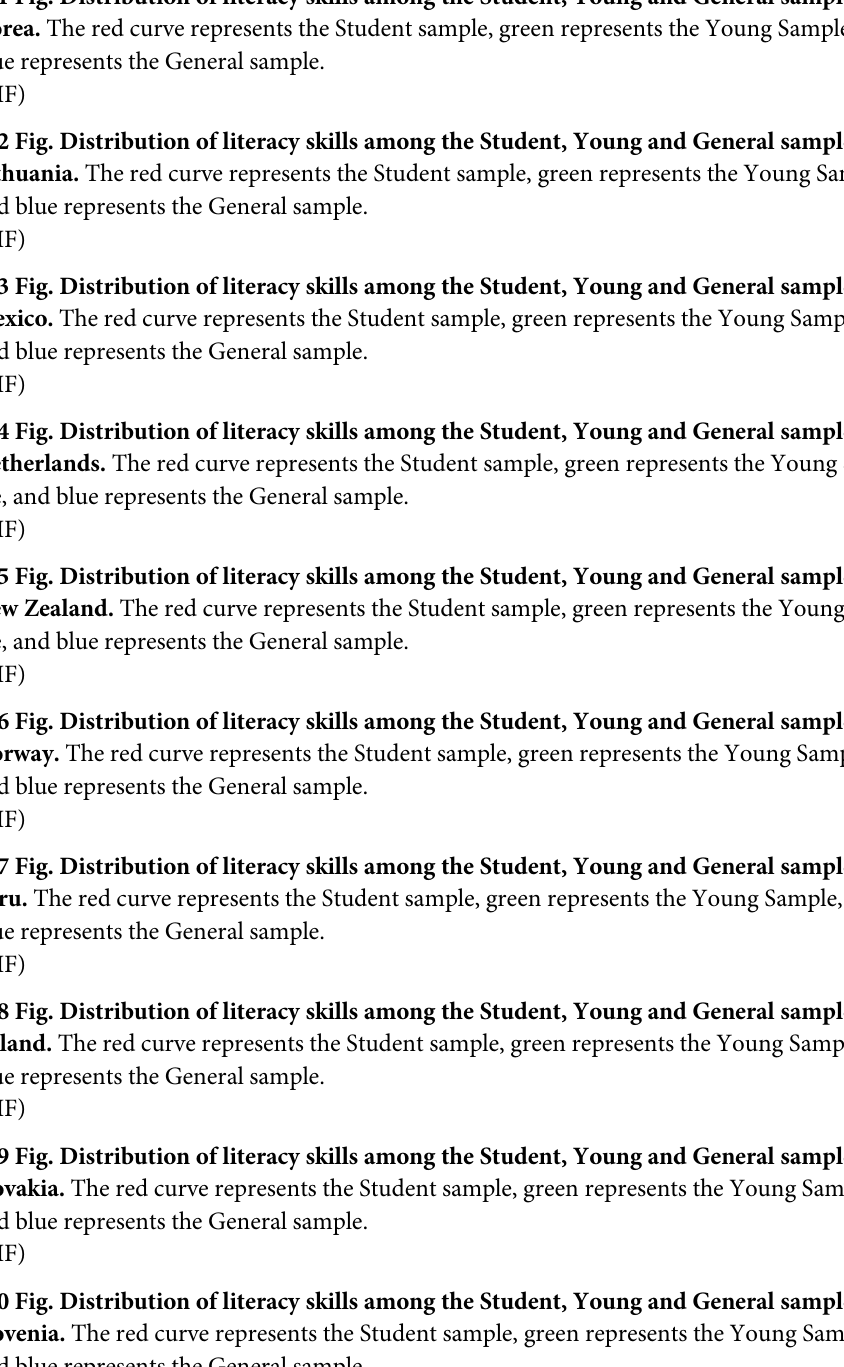
Sample, and blue represents the General sample. (TIF) S21 Fig. Distribution of literacy skills among the Student, Young and General samples of Korea. The red curve represents the Student sample, green represents the Young Sample, and blue represents the General sample. (TIF) S22 Fig. Distribution of literacy skills among the Student, Young and General samples of Lithuania. The red curve represents the Student sample, green represents the Young Sample, and blue represents the General sample. (TIF) S23 Fig. Distribution of literacy skills among the Student, Young and General samples of Mexico. The red curve represents the Student sample, green represents the Young Sample, and blue represents the General sample. (TIF) S24 Fig. Distribution of literacy skills among the Student, Young and General samples of Netherlands. The red curve represents the Student sample, green represents the Young Sam- ple, and blue represents the General sample. (TIF) S25 Fig. Distribution of literacy skills among the Student, Young and General samples of New Zealand. The red curve represents the Student sample, green represents the Young Sam- ple, and blue represents the General sample. (TIF) S26 Fig. Distribution of literacy skills among the Student, Young and General samples of Norway. The red curve represents the Student sample, green represents the Young Sample, and blue represents the General sample. (TIF) S27 Fig. Distribution of literacy skills among the Student, Young and General samples of Peru. The red curve represents the Student sample, green represents the Young Sample, and blue represents the General sample. (TIF) S28 Fig. Distribution of literacy skills among the Student, Young and General samples of Poland. The red curve represents the Student sample, green represents the Young Sample, and blue represents the General sample. (TIF) S29 Fig. Distribution of literacy skills among the Student, Young and General samples of Slovakia. The red curve represents the Student sample, green represents the Young Sample, and blue represents the General sample. (TIF) S30 Fig. Distribution of literacy skills among the Student, Young and General samples of Slovenia. The red curve represents the Student sample, green represents the Young Sample, and blue represents the General sample.